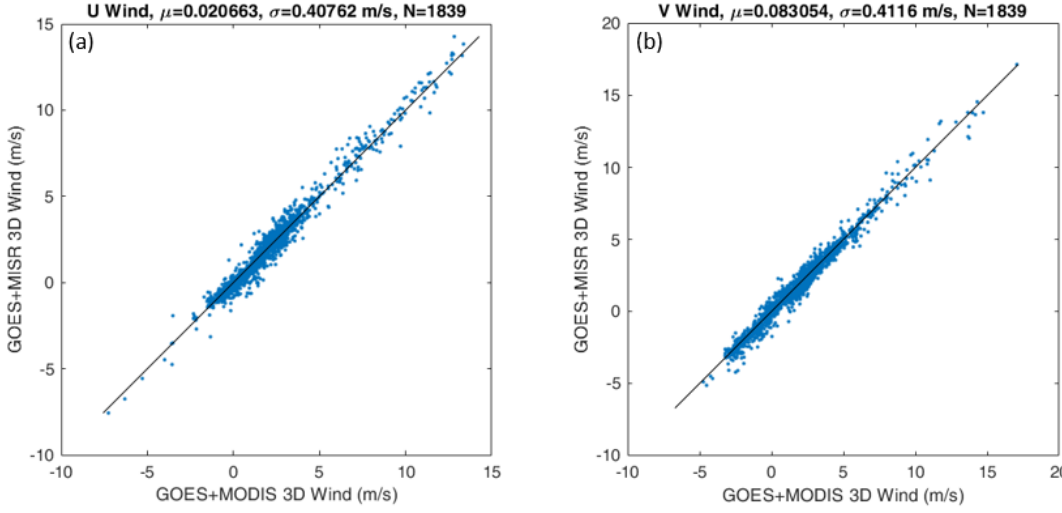
Figure 18. Retrieved winds from MODIS and GOES are compared to retrievals from MISR and GOES in the U ( + East) and V ( + North) directions on the tangent plane to the WGS84 ellipsoid in ( a ) and ( b ) respectively. The diagonal line is the perfect match, and robust statistics (mean µ and standard deviation σ , over sample size N) are computed over the retrieval di ff erences. The Median Absolute Di ff erence (MAD) filter technique is used with a six-sigma threshold to edit out spurious pairings then the regular mean and standard deviation are computed over the remaining population. The MODIS granule is MOD2018196.1700.061 (MODIS Band 1) and is simultaneous with MISR Path 24, Orbit 98797.